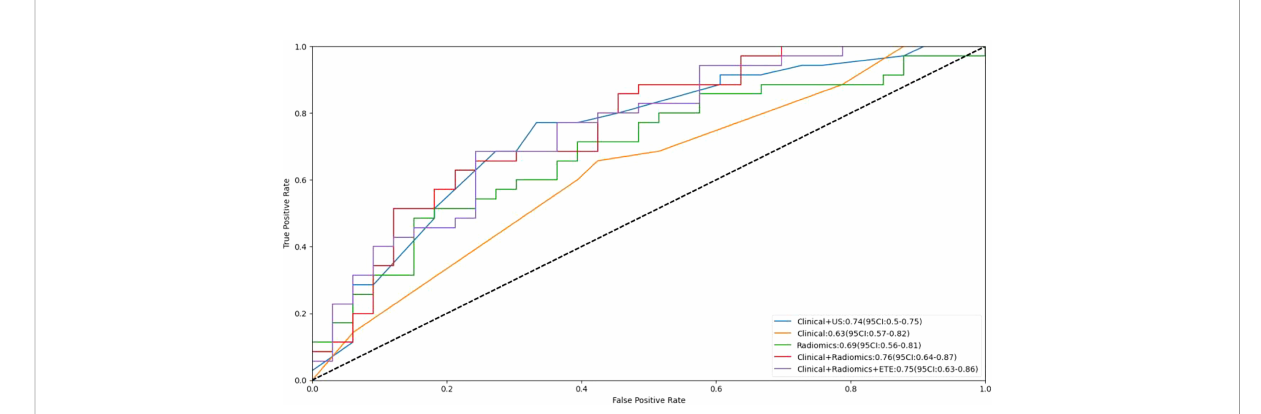
FIGURE 4 Receiver operating curves (ROC) for the models. US, ultrasound; ETE, extrathyroidal extension .